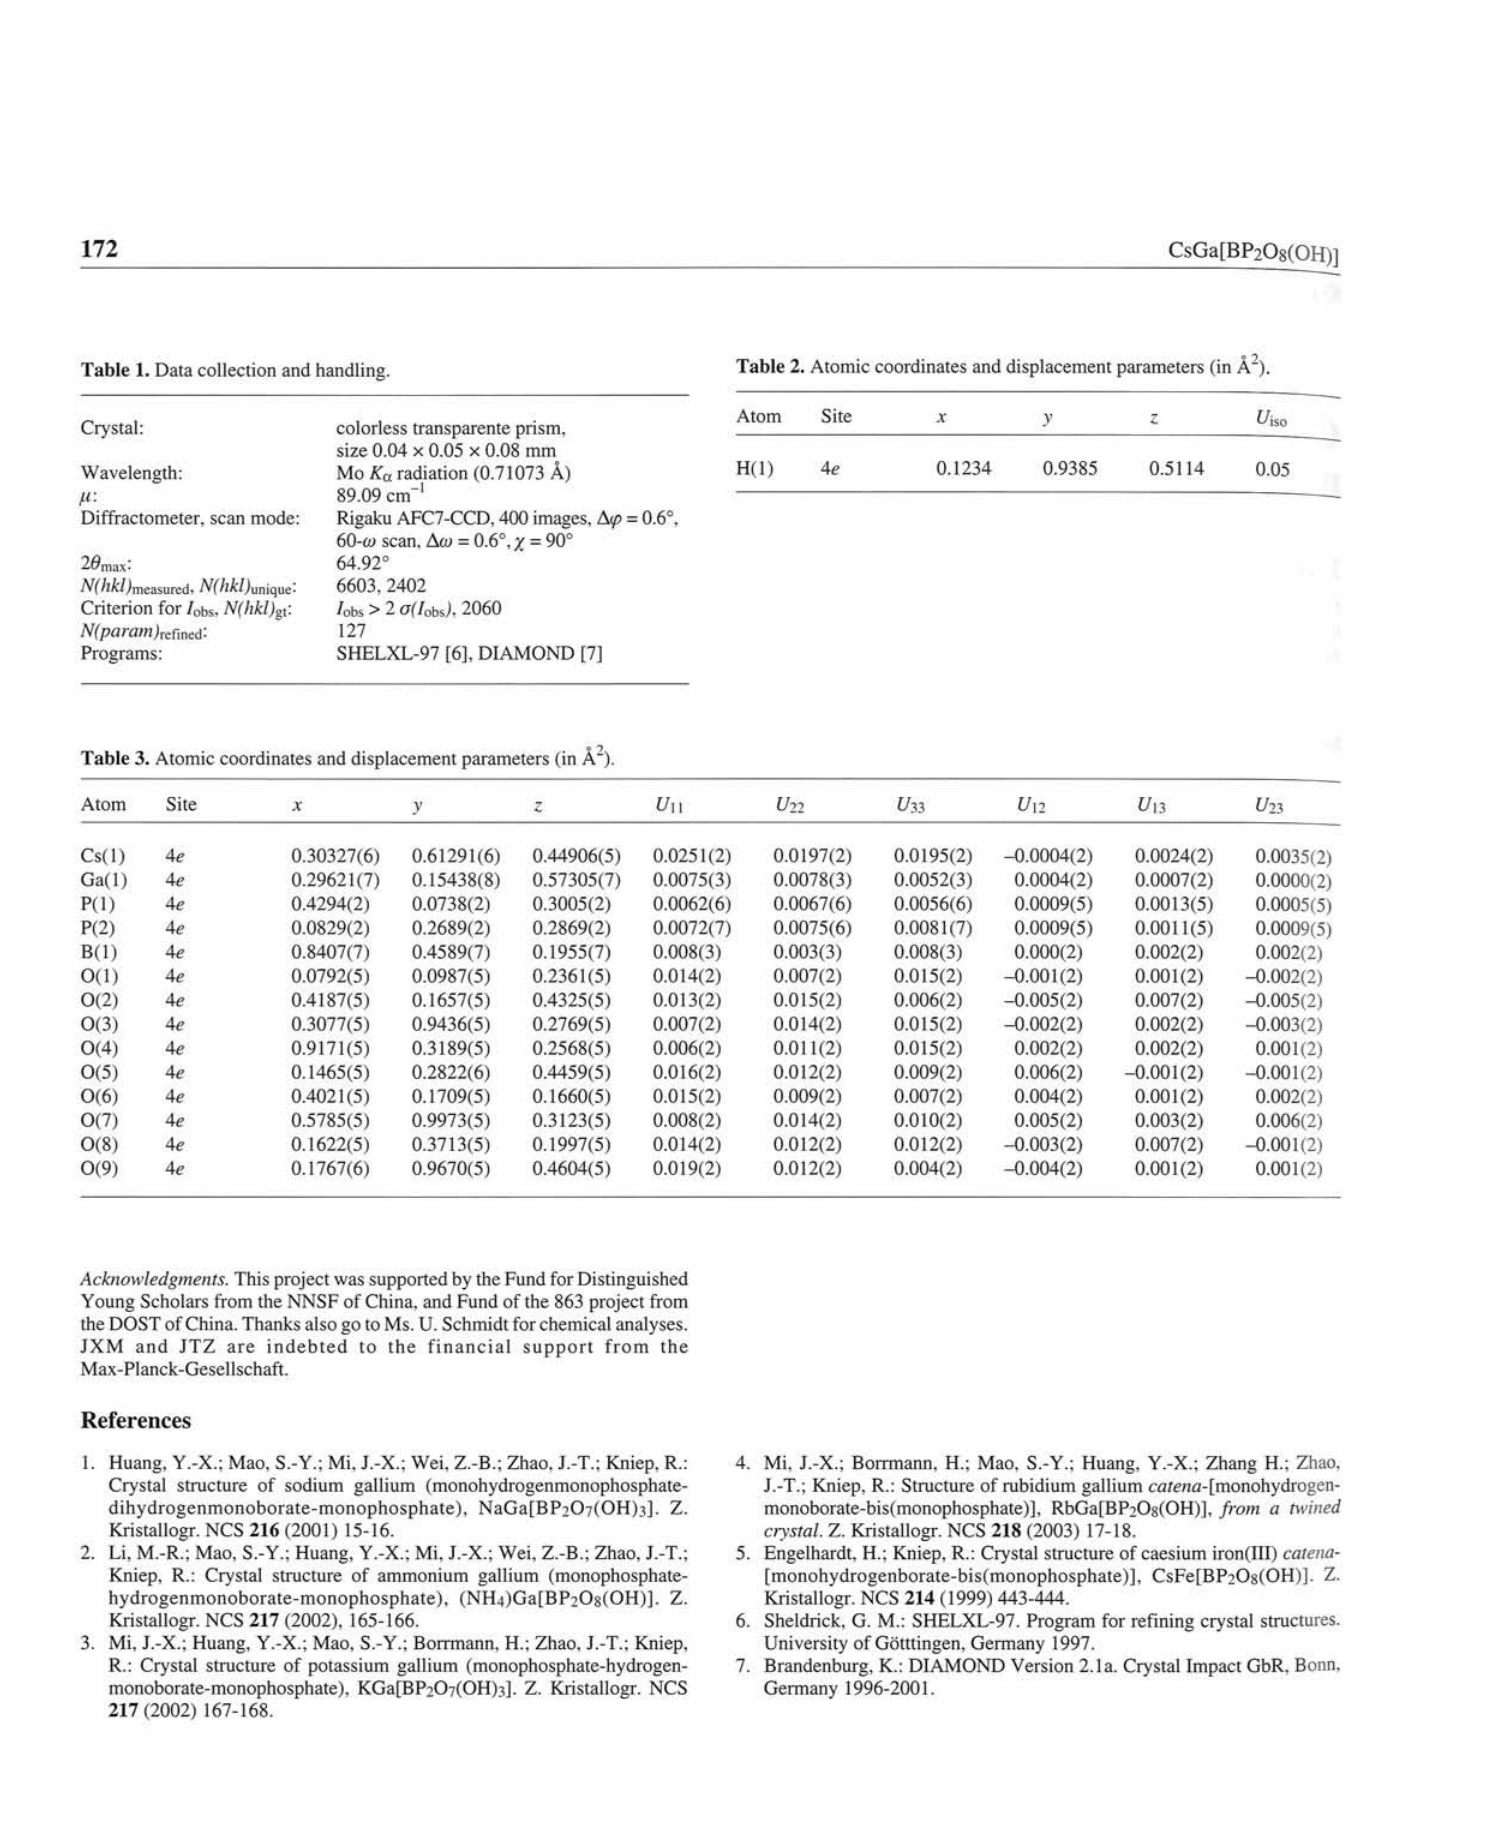
Table 3. Atomic coordinates and displacement parameters (in Â 2